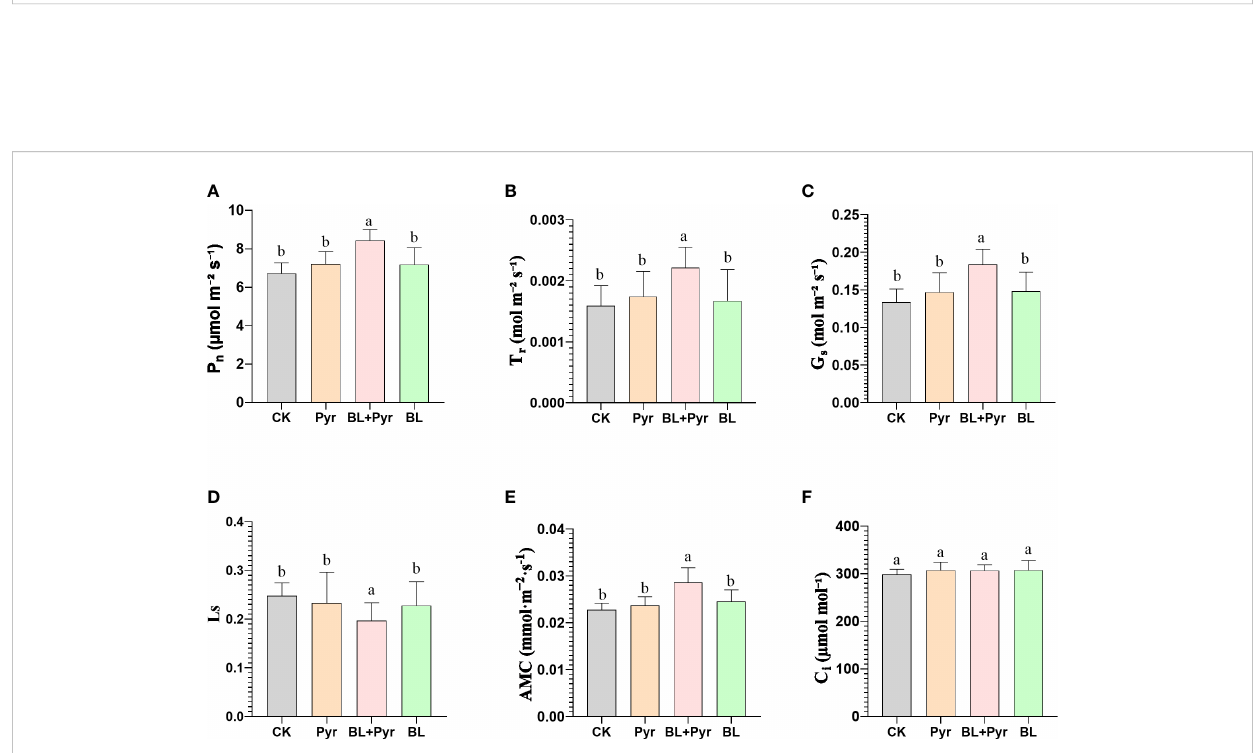
FIGURE 3 BL+Pyr showed a synergistic effect on increasing the photosynthetic ef fi ciency by enhancing the gas exchange process. (A) Net photosynthetic rate (P n ); (B) Transpiration rate (T r ); (C) Stomatal conductance (G s ); (D) Stomatal restriction value (L s ); (E) Apparent mesophyll conductance (AMC); (F) Intercellular CO 2 concentrations (C i ). Data are presented as the mean ± SD of three independent replicate experiments. Different letters indicate signi fi cant differences (p< 0.05) according to ANOVA followed by Tukey ’ s test. 31-day-old seedlings (the 11 th day after the fi rst-round application) were used. CK, untreated seedlings; Pyr, seedlings treated with 3 m M pyraclostrobin; BL+Pyr, seedlings treated with 1 m M BL and 3 m M pyraclostrobin; BL, seedlings treated with 1 m M